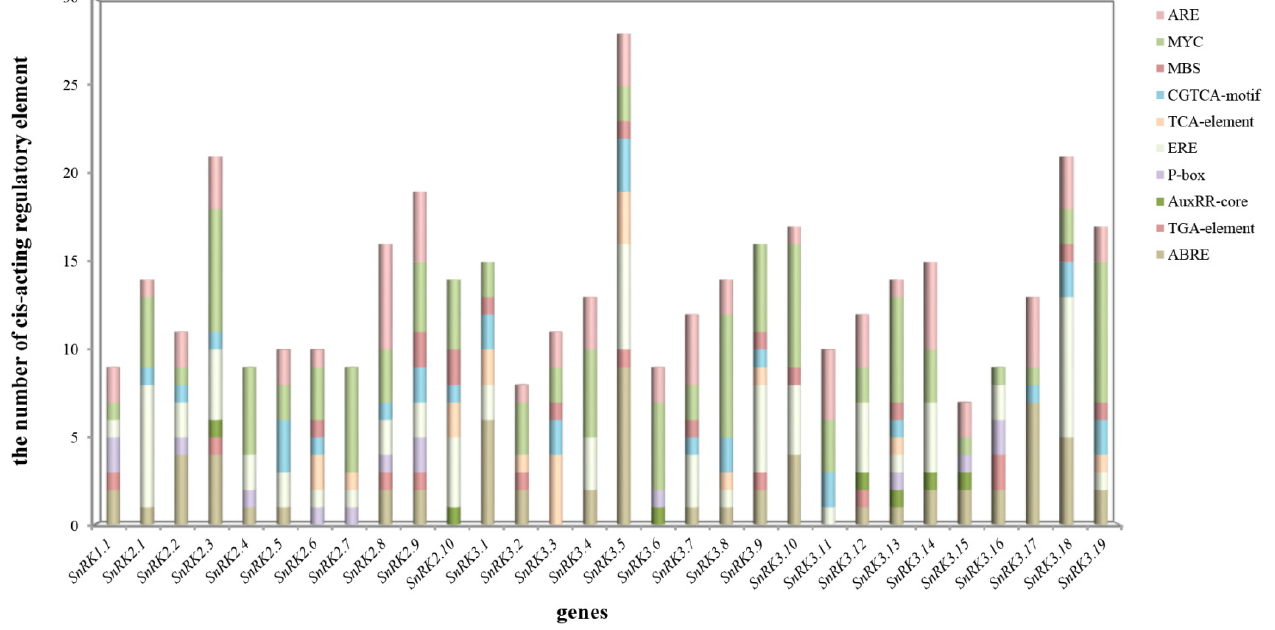
Figure 5. Predicted cis-acting regulatory elements in CsSnRK promoters. Different colors represented different cis-elements.